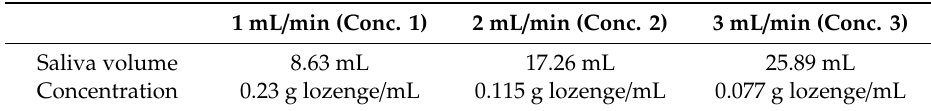
Table 1. Solvent volumes for one isla ® medic lozenge. Determined by the sucking time for one lozenge and a stimulated salivary flow rate of 1 mL / min, 2 mL / min, and 3 mL / min. 1 mL / min (Conc. 1) 2 mL / min (Conc.